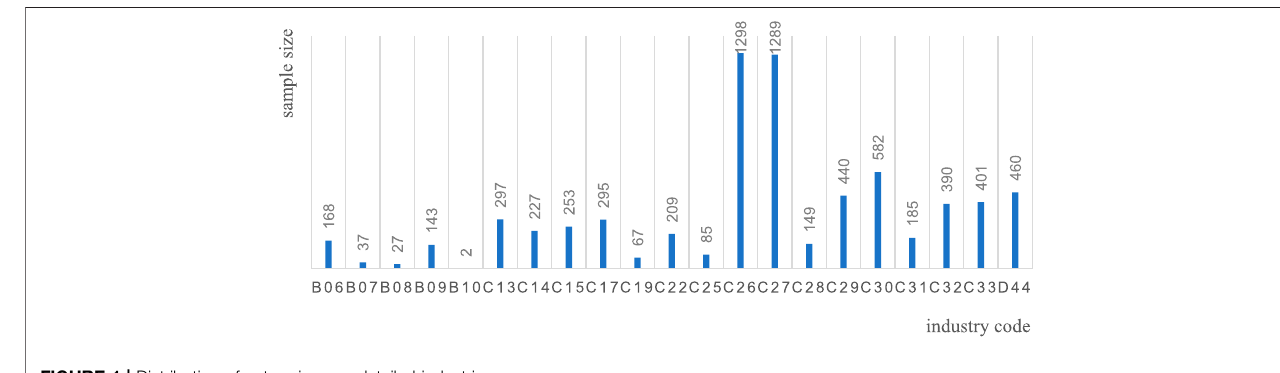
FIGURE 1 | Distribution of enterprises on detailed